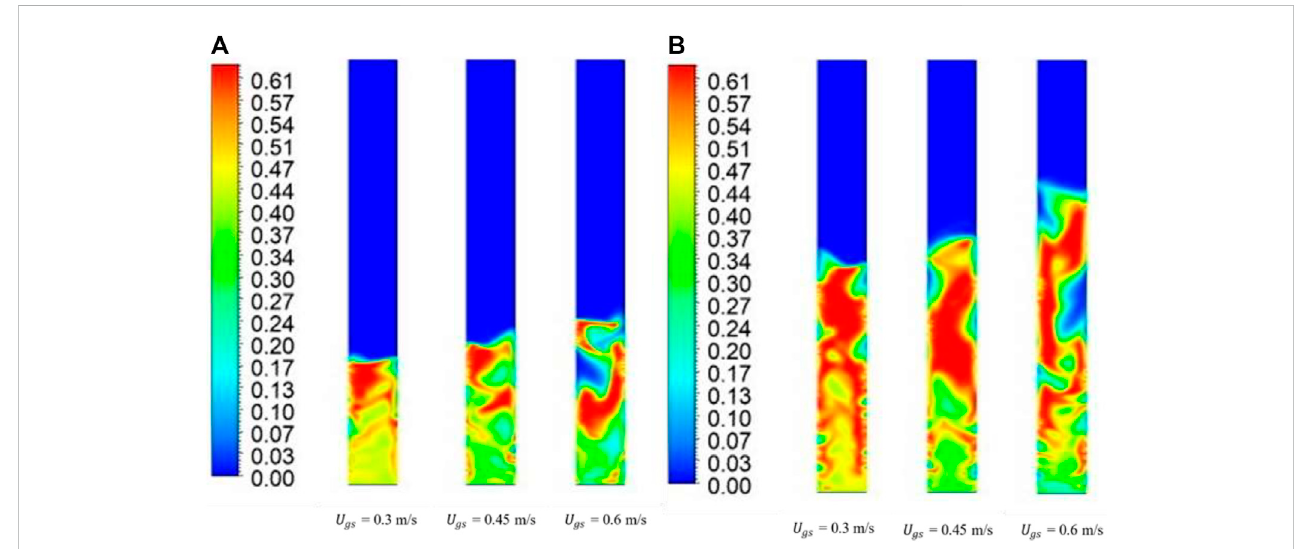
FIGURE 8 Time-averaged steady-state solid-phase volume fraction contours for 40% mixture at (A) 0.335 m bed height and (B) 0.635 m bed height.